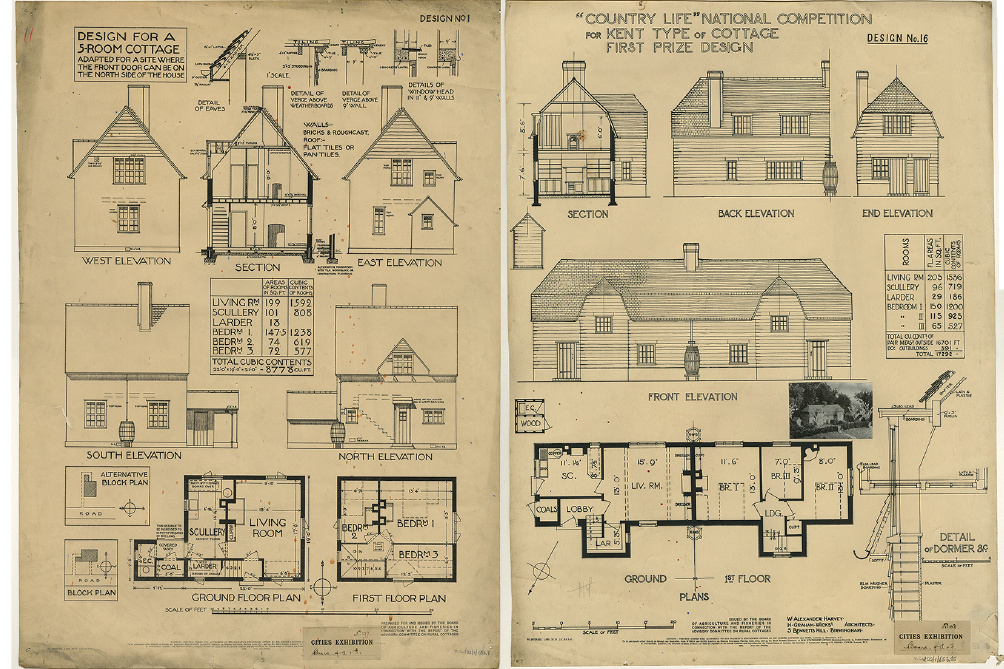
Figure 3. House type drawings by the Board of Agriculture and Fisheries, in connection with the Report of the Advisory Committee on Rural Cottages. Source: Patrick Geddes Papers